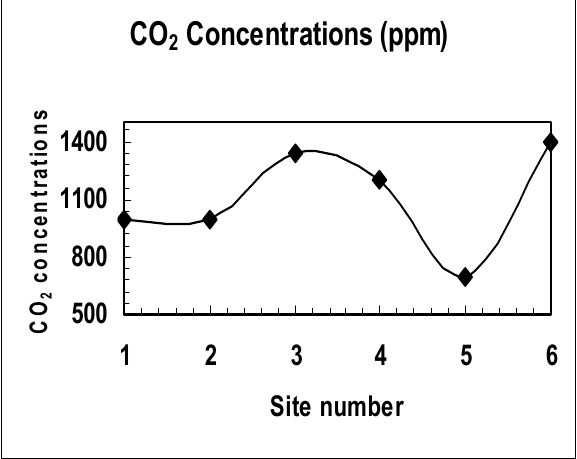
concentration with the site 2